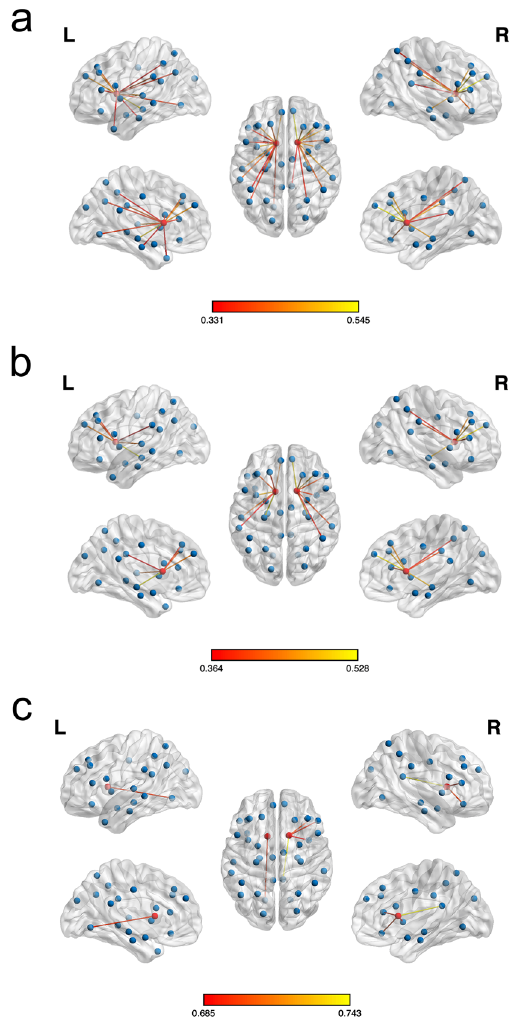
Figure 1. The Spearman correlation coefficients of the entire population ( a ), PD No-OH ( b ) and PD + OH ( c ) are expressed as the edges between the caudate and the ROIs. The degree of correlation is expressed with color; the brighter is the connection, the stronger it is. ( a ) In the analysis of all patients studied, the caudate nucleus maintained a moderate degree of association with the prefrontal areas; insula; hippocampus; parahippocampus; posterior cingulate gyrus; lingual gyrus; superior/inferior parietal gyrus; and the supramarginal, angular, superior temporal, and temporal pole areas. ( b ) In PD No-OH, the caudate-refenced associations with the dorsolateral and medial superior frontal, middle/inferior frontal gyrus, insula, hippocampus, inferior parietal gyrus, supramarginal gyrus, and superior temporal gyrus remained significant. However, the number of significant connections was reduced compared to the whole population, and degrees of correlation remained moderate. ( c ) PD + OH patients manifested different traits. Most of the observed connections of the left caudate nucleus lost their significance, except the correlation with the left lingual gyrus. A few links between the right caudate and right inferior frontal gyrus, insula, and posterior cingulate gyrus remained significant. Of note, the strength of the remaining connections increased. The figures were made with BrainNET Viewer, a graphical user interface (version 1.7; http//www. nitrc. org/ proje cts/